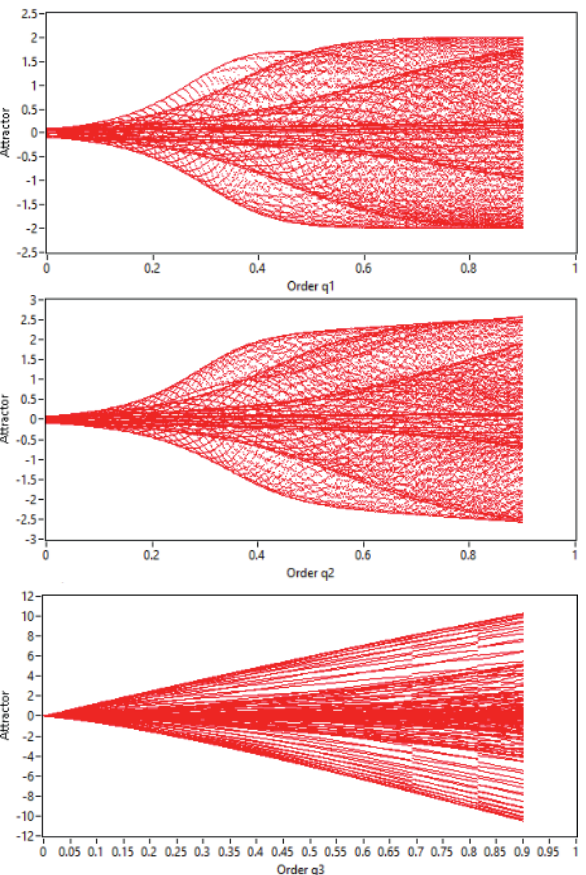
Fig. 6: Bifurcation plot State versus fractional orders.